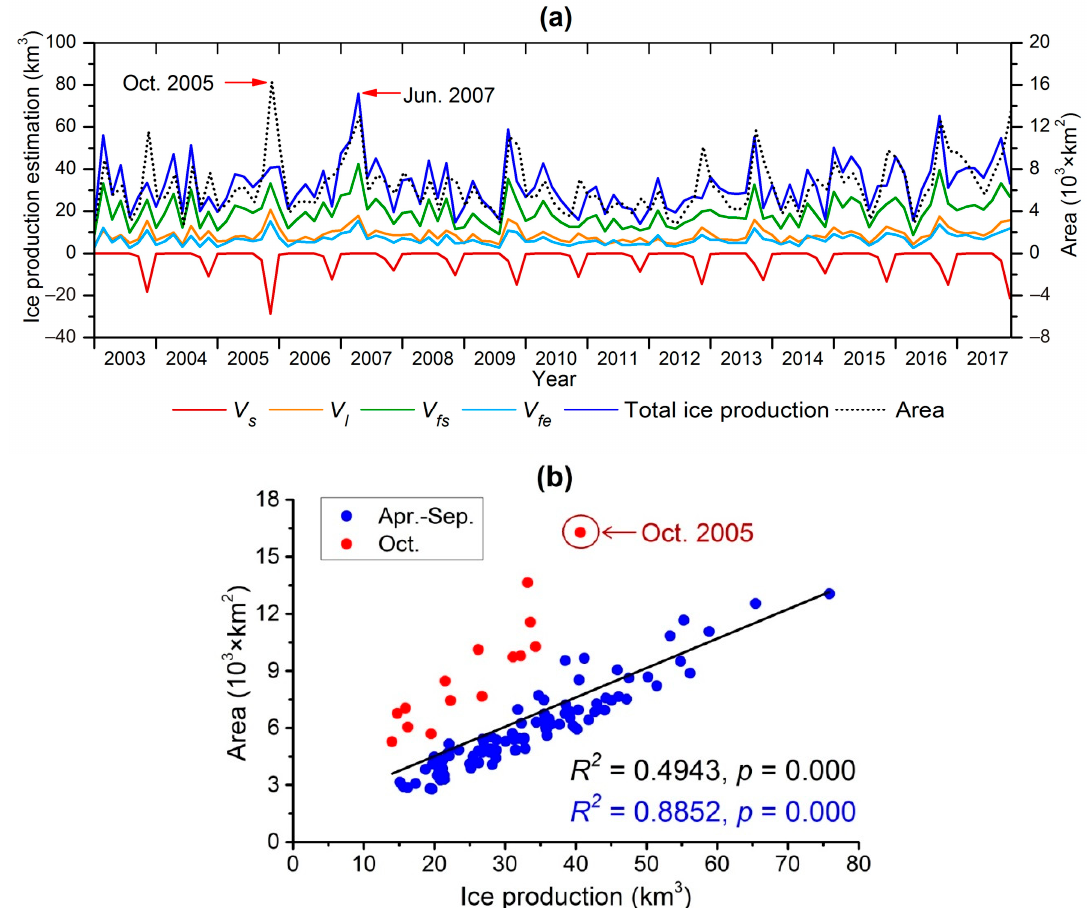
Figure 3. ( a ) Time series of monthly polynya area, ice production and its four components, V s , V I , V fs and V fe from 2003 to 2017, restricted to April to October. ( b ) Linear regression between monthly polynya area and ice production. Blue points refer to April to September data, and red points to October data. R 2 , p -value and fitting line in black refer to all points, and values in blue refer to the blue points.